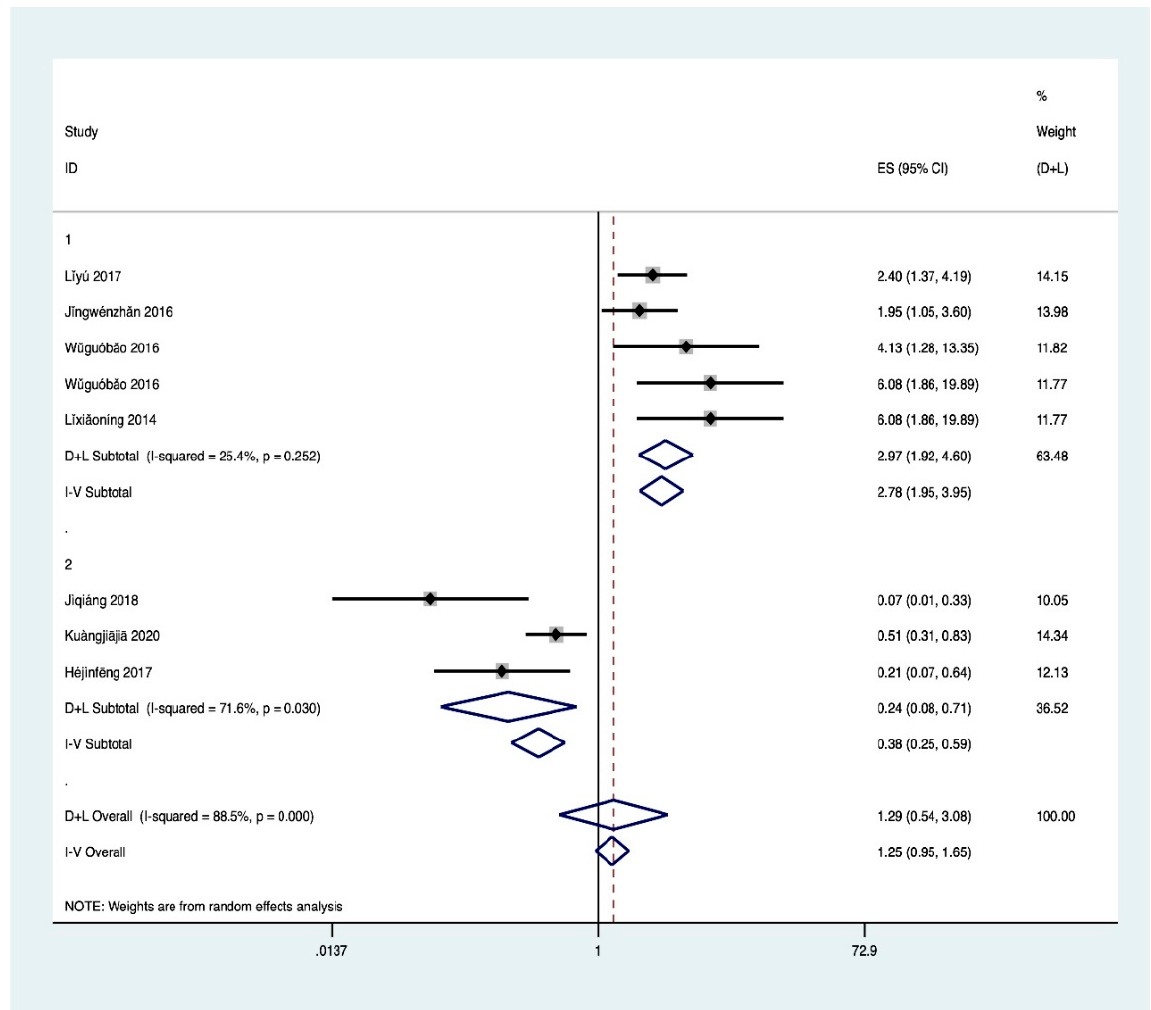
Figure 3. Meta for BH. 1: health information attention; 2: online game time. Meta-analysis results (Figure 4) showed that the heterogeneity of the four associated factors of FE was large. After the exclusion of relevant studies by sensitivity analysis, the heterogeneity of father’s education level and mother’s education level decreased (I 2 = 25.10%, p = 0.171; I 2 = 12.00%, p = 0.325), and was significantly associated with HL (Z = 11.06, p < 0.001; Z = 9.44, p < 0.001). Therefore, fixed effect was selected for analysis, and it was found that higher educational level of fathers (OR 1.86, 95% CI, 1.7–2.04) and mothers (OR 1.76, 95% CI, 1.58–1.96) was associated with higher probability of HL of their children. Although the heterogeneity of single-child and family income also decreases, it still has certain heterogeneity. As a result, random effect was selected for analysis. The researchers found these two factors were significantly correlated with HL (Z = 3.28, p < 0.05; Z = 5.44, p < 0.001), and only children (OR 2.23, 95% CI, 2.38–3.62) and higher family income level (5.06, 95% CI, 2.82–9.08) are protective factors of HL. In addition, the results suggested publication bias for parents’ education level (farther: Egger’s test p = 0.001; mother: Egger’s test p = 0.002) and single-child (Egger’s test p =